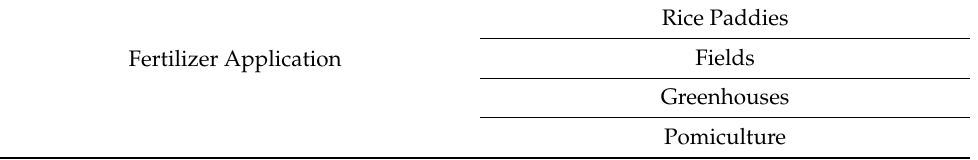
Table 6. The classification system of fertilizer-use agricultural land emission sources considering Method III.